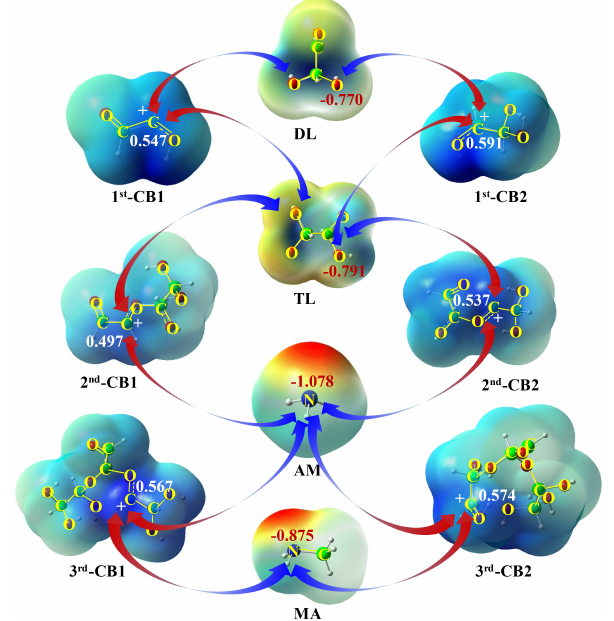
Figure 2. The driving force for oligomerization without and with MA / AM: the natural bond orbitals of DL, TL, MA, AM, and CBs (in